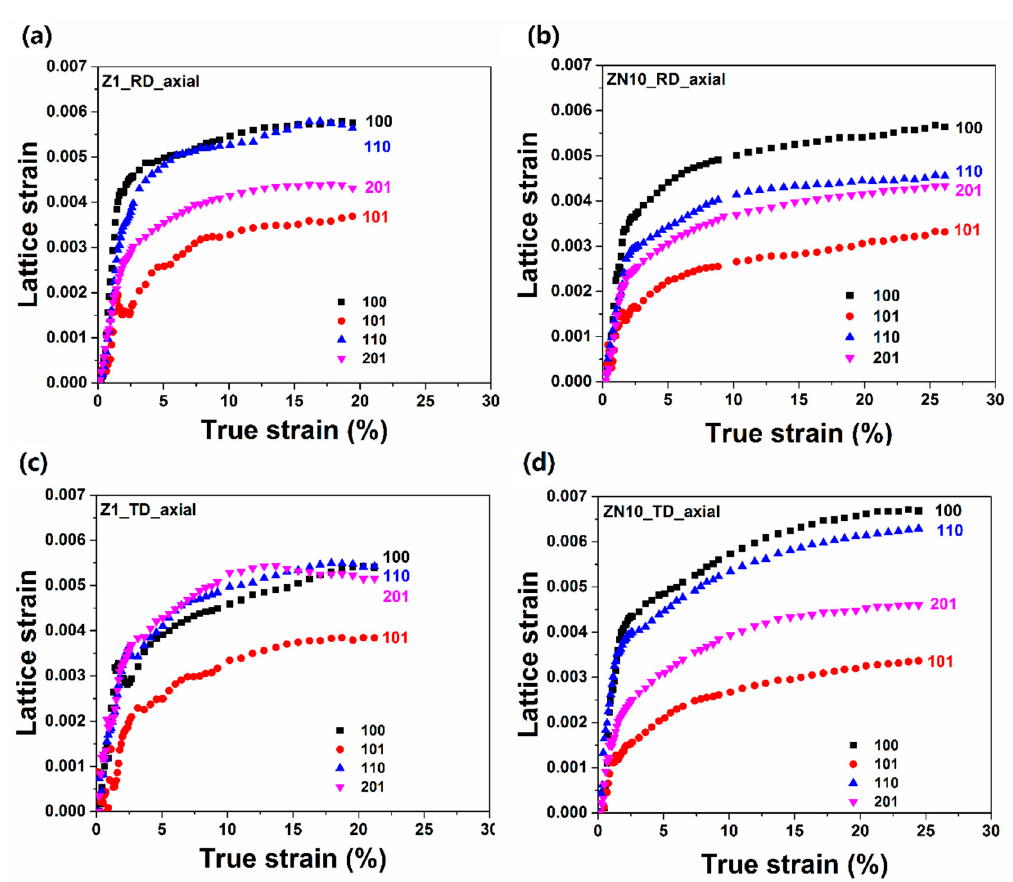
Figure 9. Lattice strain evolution of Z1 and ZN10 during tension along loading direction: ( a ) Z1 in RD; ( b ) ZN10 in RD; ( c ) Z1 in TD; ( d ) ZN10 in TD.